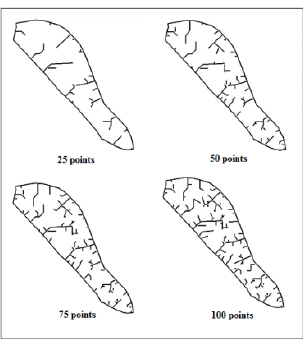
Figure 7. Result of Simulation for Different Runs of Prototype Model